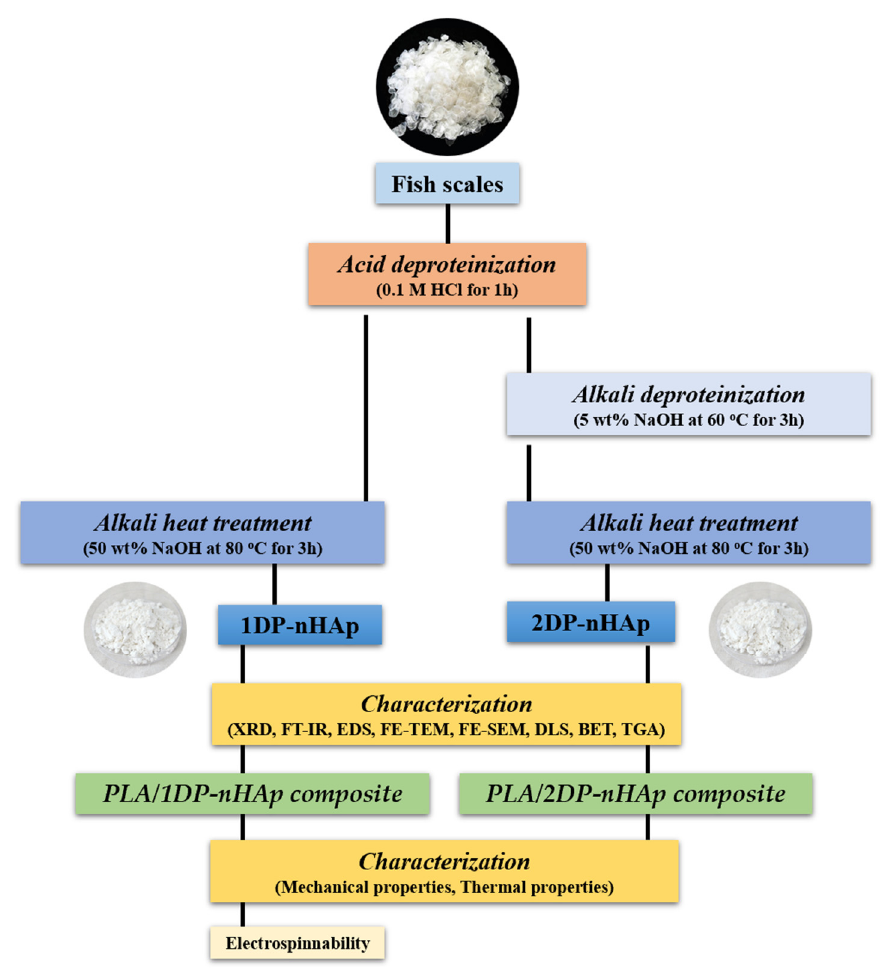
Figure 1. Schematic diagram showing the preparation of nHAp from white seabass scales by alkali heat treatment method.